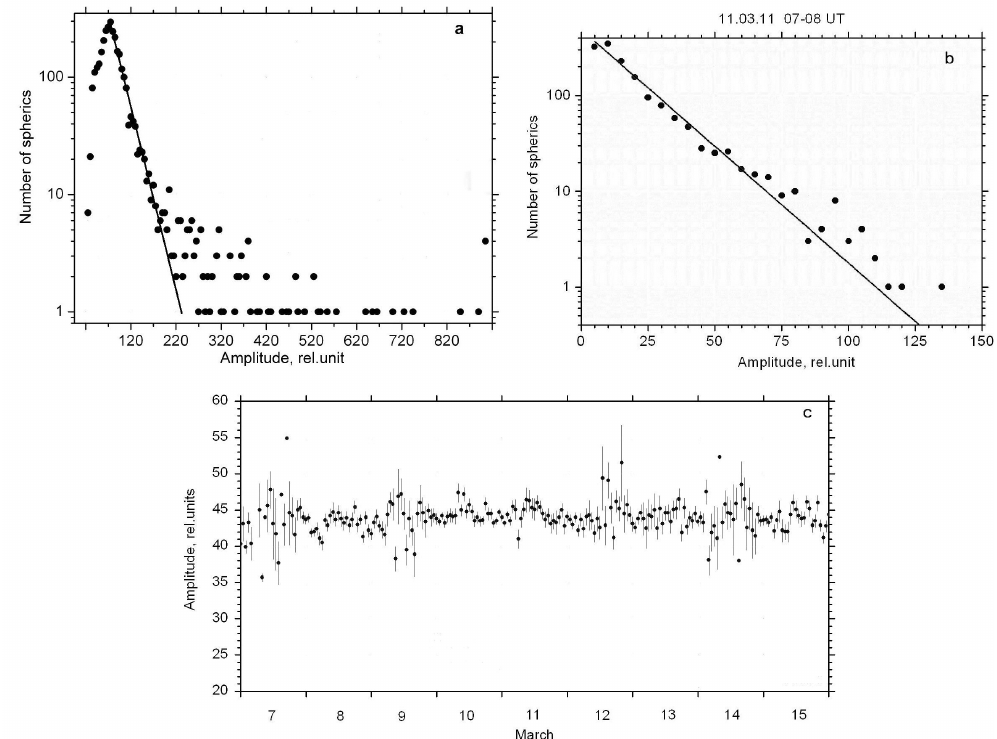
Fig. 4. Amplitude distributions of the signals received in Yakutsk at 07:00–08:00 UT of 11 March 2011 (a) , and registered by the WWLLN system in that time interval at distances of 6000–10000km from Yakutsk and in the azimuthal sector corresponding to the 2nd zone (b) . The behavior of the signals amplitude calculated from the data of WWLLN network during the strong EQ in the area defined by distances of 6000–10000km from Yakutsk and the azimuthal sector corresponding to the 2nd zone (c)